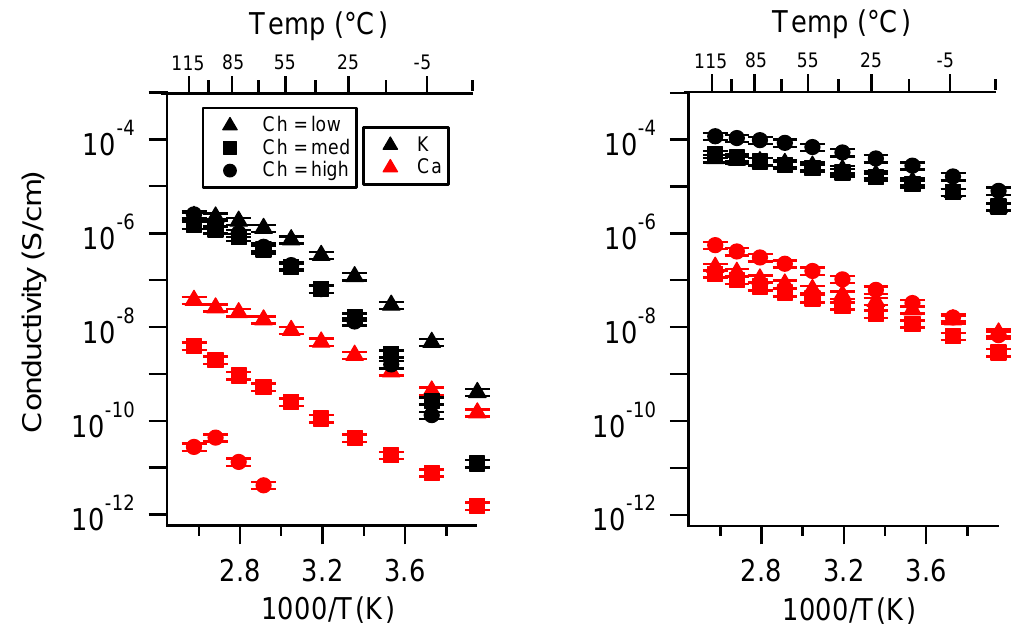
Figure A13. (Reproduced from main text) Conductivity as a function of charge density for PEGDMA1000_SSM (left) and PTHFDA_STFSI1000 (right) SIPEs swelled with DEG. Temperatures ranged from − 20 °C to 115 °C. Note that there may be a non ‐ negligible fraction of electronic conductivity in conditions where conductivity of less than 10 − 9 S/cm is reported.